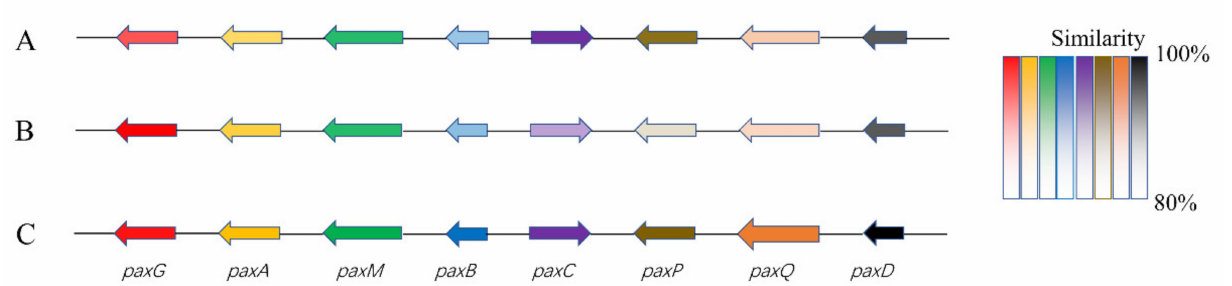
Figure 6. Schematic comparison of the putative BGC (pax) of paxilline found in B9 ( A ), reference genome ( B ), and literature ( C ). ( A ). The presumptive pax cluster in the B9 genome (B9 pax ); ( B ). The presumptive pax cluster in reference genome (GCA_000347475) of P. paxilli ATCC 26601 (PP pax ); ( C ). The defined pax gene cluster (BGC0001082; PAX) [23]. Different colors represent different genes, and the degree of similarities is distinguished by color shade.